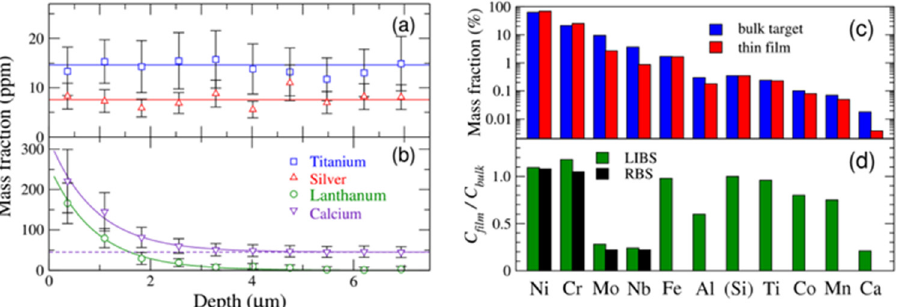
Figure 18. ( a , b ) Depth-resolved analysis of optical glass: evidence of surface contamination due to polishing [201]. ( c ) Analysis of a thin alloy film, deposited by pulsed laser deposition, and the bulk target. ( d ) Evidence of non-stoichiometric mass transfer from the target to the film. Adapted from Reference [202].